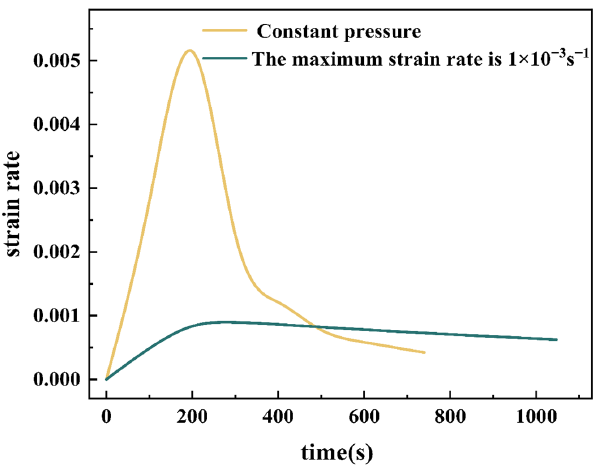
Figure 8. Maximum strain rate at constant pressure vs. maximum strain rate of 1 × 10 − 3 s − 1 .